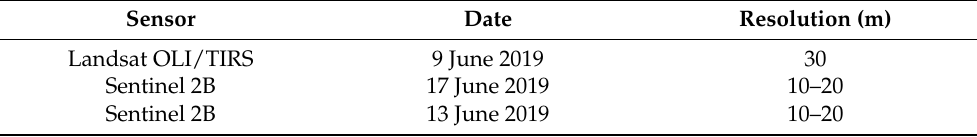
Table 1. Data sources Satellite Images with their Acquisition Date and Spatial Resolution.